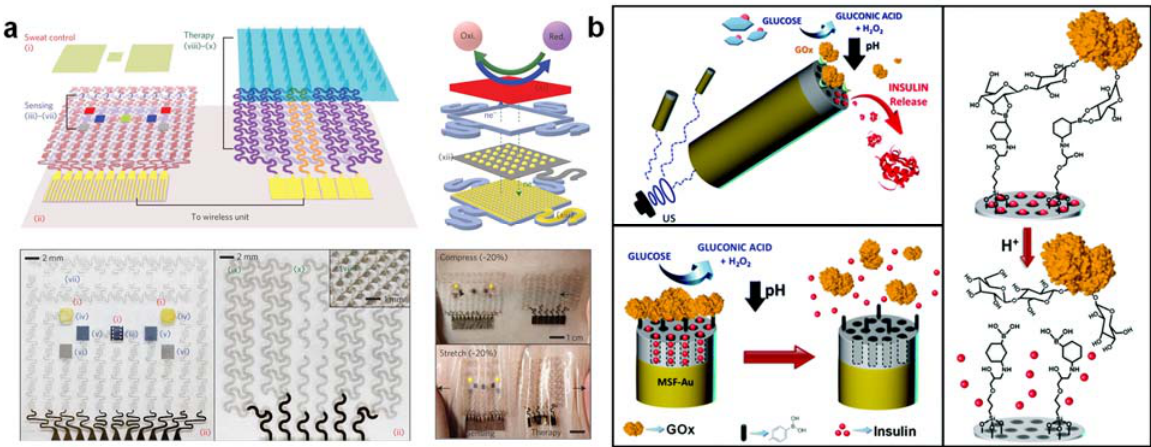
Figure 7. ( a ) A graphene ‐ based electrochemical device with thermoresponsive microneedles for di ‐ abetes monitoring and treatment. For explanation for (i)–(vi) in subfigure a, please refer to Figure 1, ref [57] . ( b ) Biomedical nanomotors for efficient glucose ‐ induced insulin release. The figures are reprinted with permission from ref [56,57]